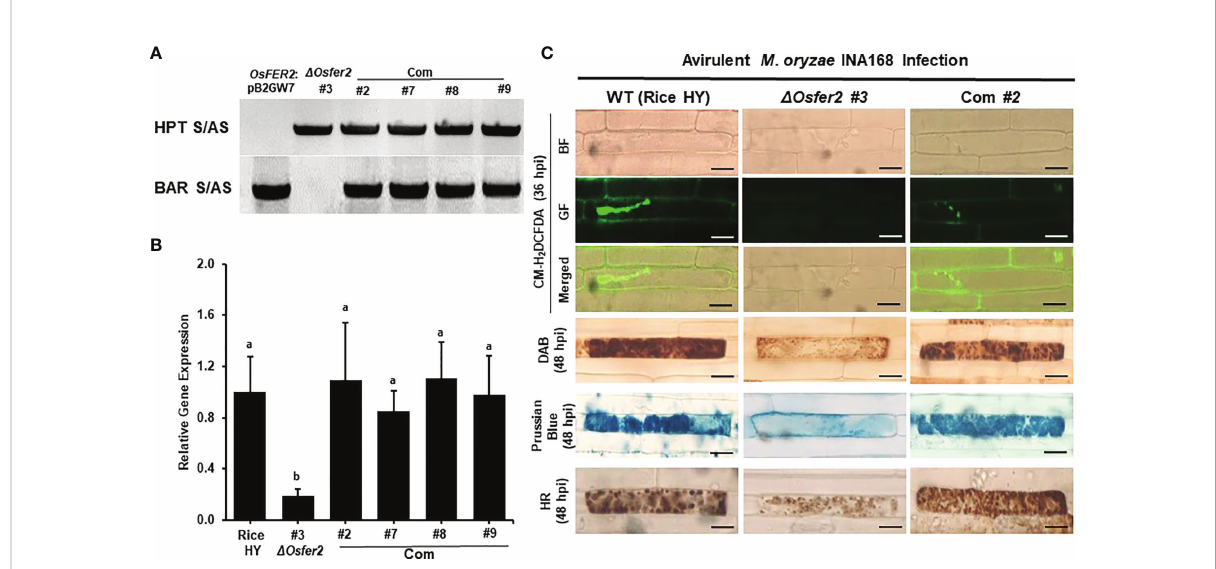
FIGURE 14 OsFER2 complementation in D Osfer2 #3 mutants restores ROS and ferric ion (Fe 3+ ) accumulation and HR cell death phenotypes in rice leaf sheaths infected with avirulent Magnaporthe oryzae INA168. (A) Identi fi cation of OsFER2 complementation in D Osfer2 #3 mutants. Hygromycin primers (HPT S/AS) were used to identify hygromycin plant selection protein in D Osfer2 background plants. BAR primers (BAR S/AS) was used to verify the presence of BAR plant selection protein in OsFER2 complementation plants. The plasmid OsFER2:pB2GW7 and gDNA of D Osfer2 were used as controls. (B) Relative OsFER2 expression in rice HY, D Osfer2 and OsFER2 complementation plants. OsFER2 expression was normalized using the expression of the internal control OsUbiquitin. Different letters above the bars indicate signi fi cantly different means ( P <0.05), as analyzed by one-way ANOVA analysis. (C) Microscopic images of rice leaf sheath epidermal cells stained with CM-H 2 DCFDA (green fl uorescence), DAB and Prussian blue (Fe 3+ , blue color) during avirulent M. oryzae INA168 infection. Images were captured using a fl uorescence microscope (Zeiss equipped with Axioplan 2) with bright fi eld and a combination of excitation (450 ‒ 490 nm) and emission (515 ‒ 565 nm) GF fi lters. The images shown are representative of the different leaf sheath samples that were observed in three independent experiments. hpi, hour post-inoculation; HR, hypersensitive response; BF, bright fi eld; GF, green fl uorescence. Scale bar=20